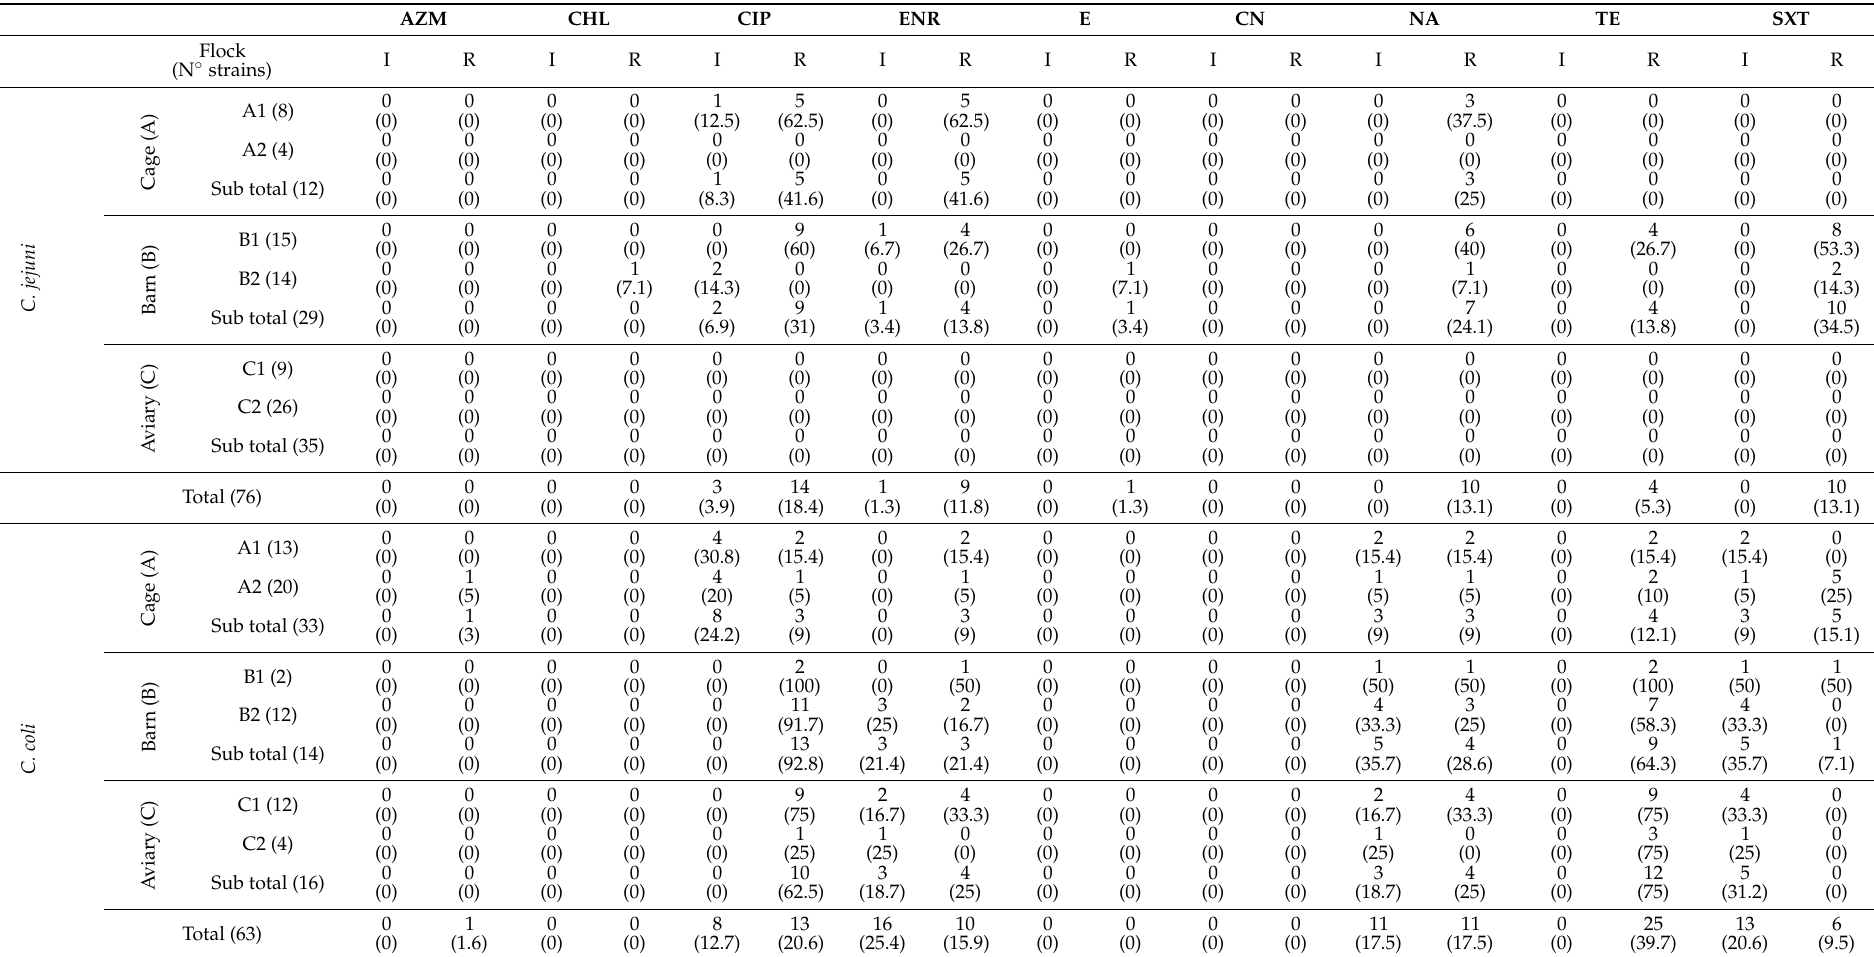
Table 4. Antibiotic resistance detected in C. jejuni and C. coli strains isolated from laying hens housed in enriched cages (A), barns (B) and aviaries